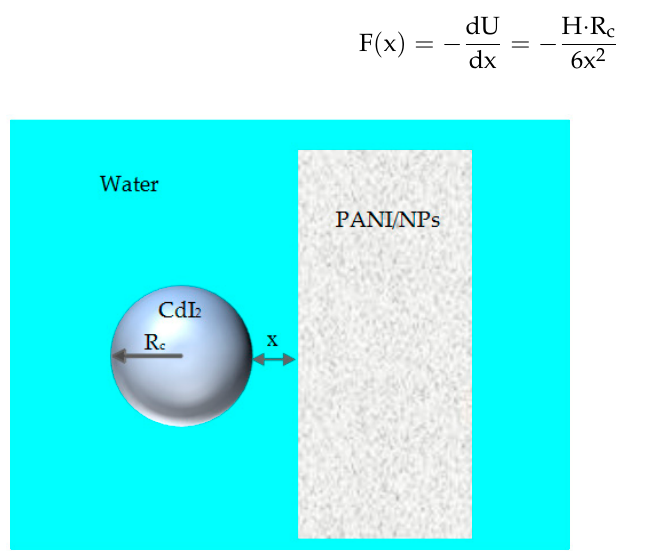
Figure 2. CdI 2 particle waste interacting with PANI/NPs across water under separating distance x<<R.